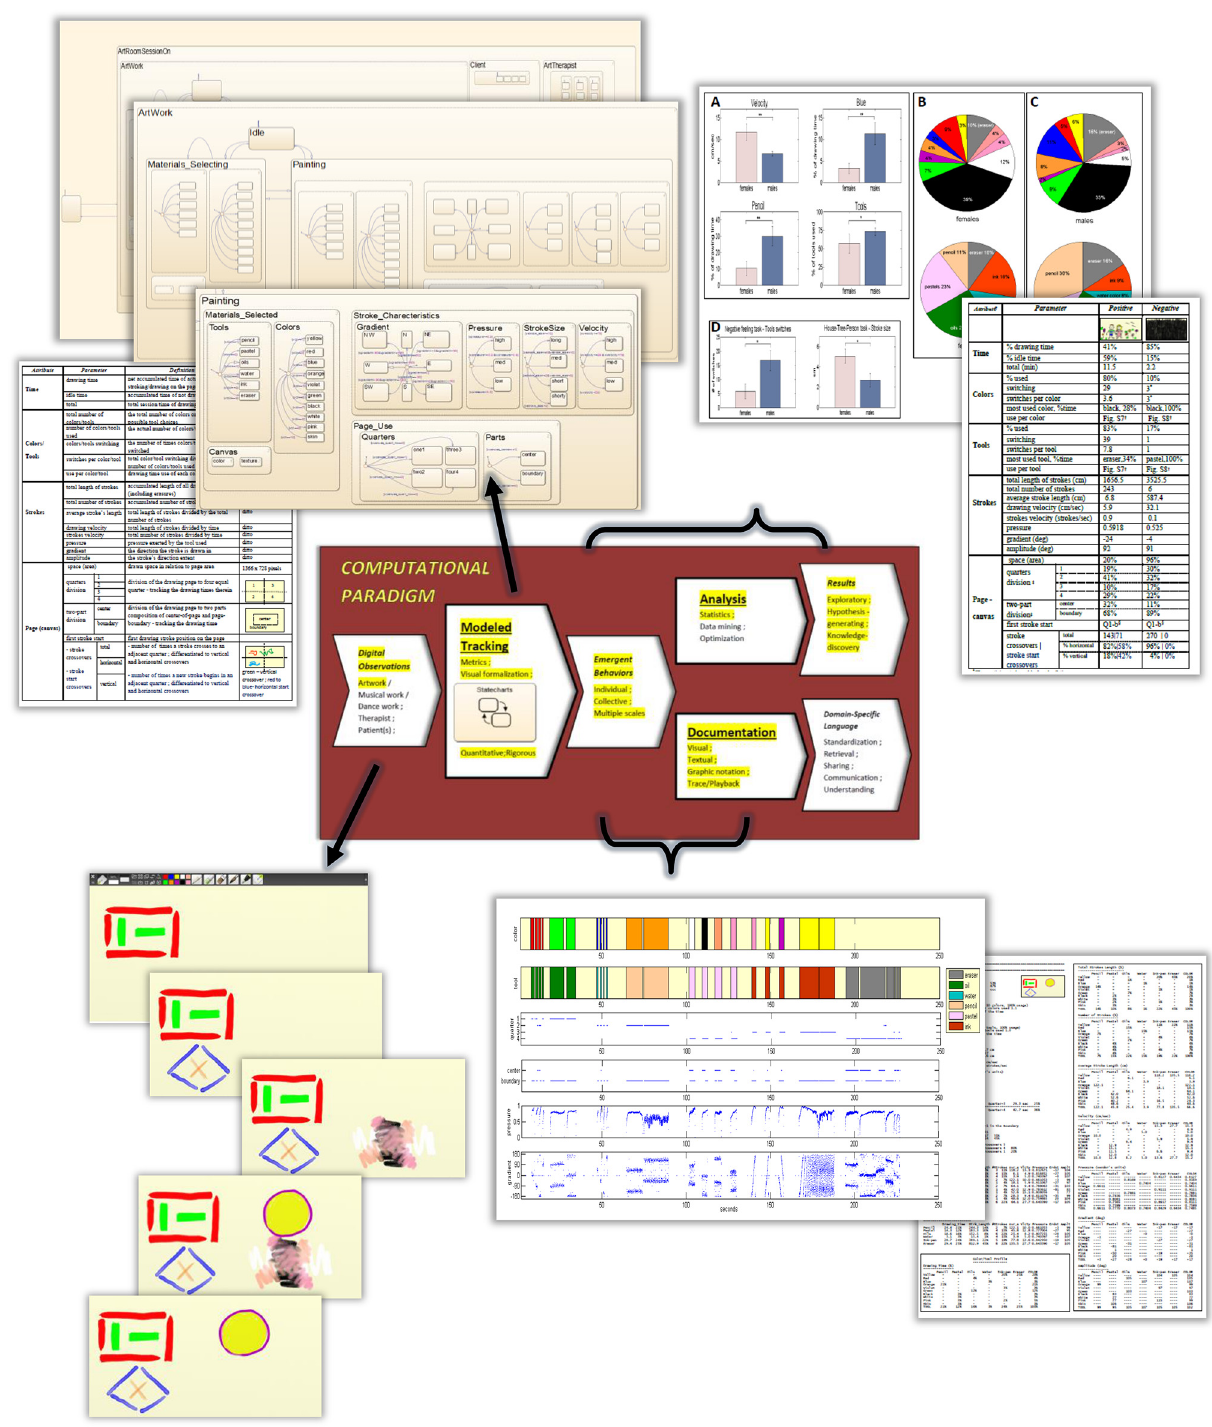
Fig 4. The paradigm applied to artwork. An illustration of the technology used in artwork: Tracking, analyzing and documenting dynamic processes in a human subjects study. Marked in yellow are the methodology ’ s capabilities utilized in this